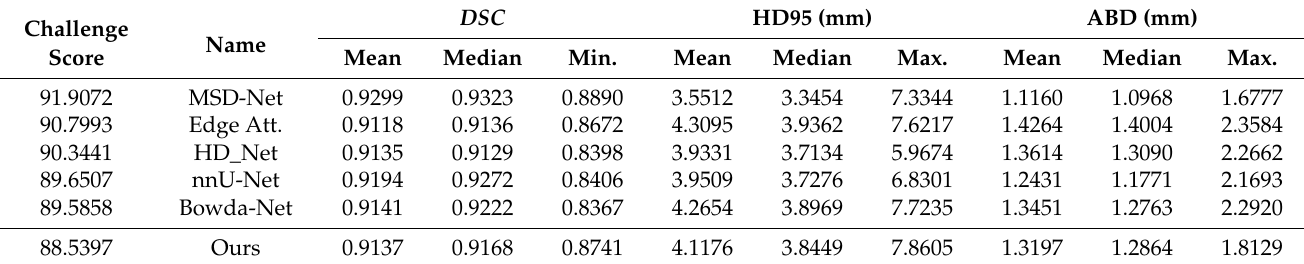
Table 4. MR model performance on “Promise12_test” along with the five best entries as of December 2020.